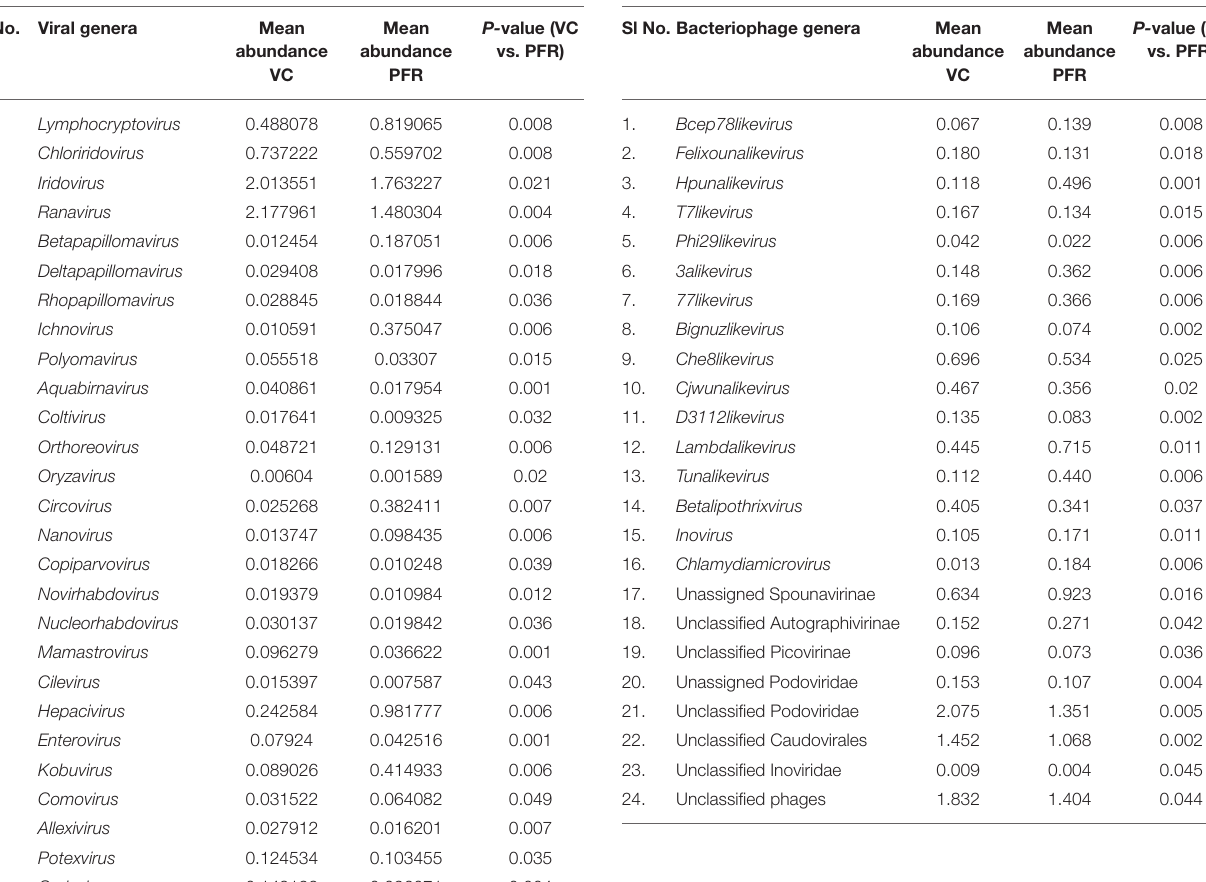
TABLE 2B | Discriminative bacteriophages in the VC and PFR groups ( P <